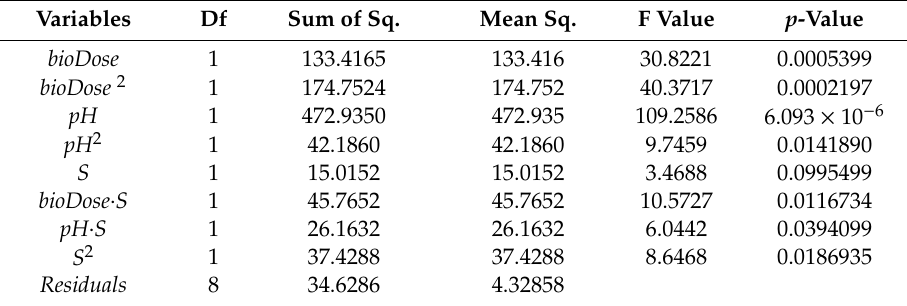
Table 4. ANOVA values for the Ni(II) remove e ffi ciency quadratic model.